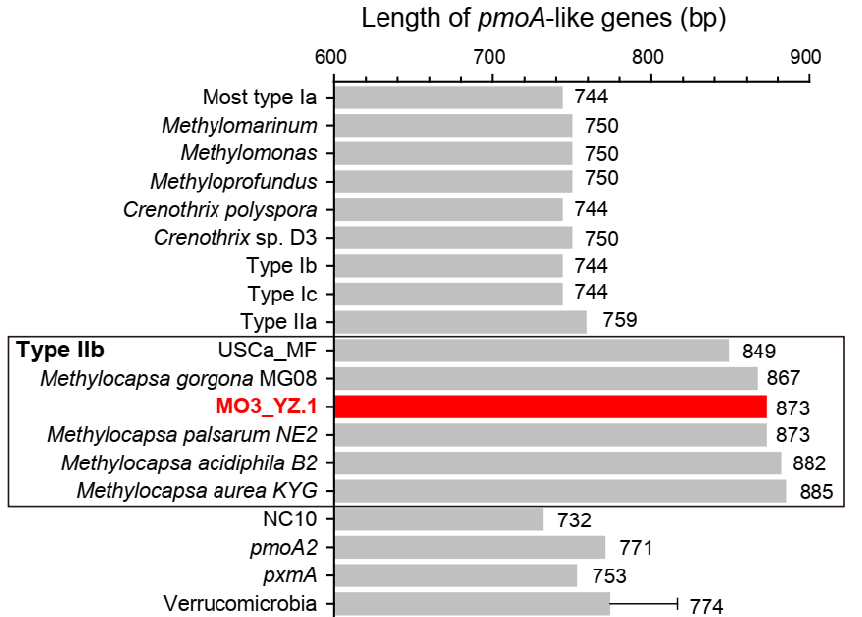
Figure 3. Length of pmoA -like genes in known methanotrophs. USCa_MF and Methylocapsa belong to family Beijerinckiaceae (type IIb). Length of Verrucomicrobia pmoA genes are shown as average value of multiple pmoA copies from several strains. The length of the pmoA2 gene of Methylocystis bryophila S285 is 762 bp according to the current version (NZ_CP019948.1, 12-APR-2021) of its genome sequence. Table S5 shows more details.